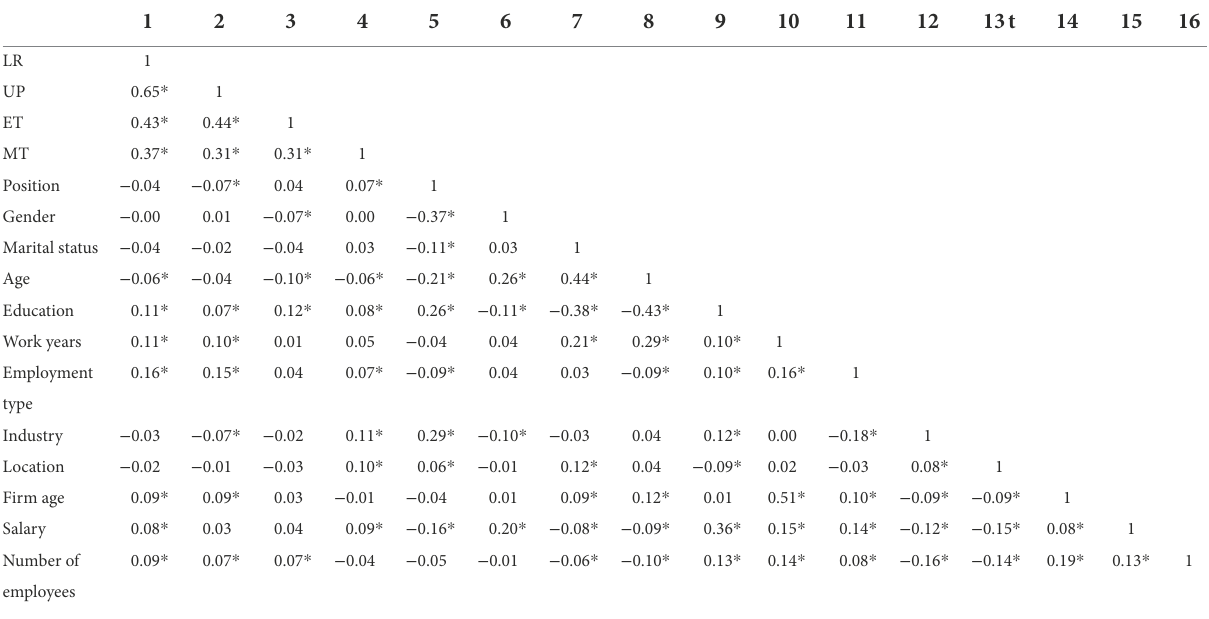
TABLE 2 Correlations and reliability of the